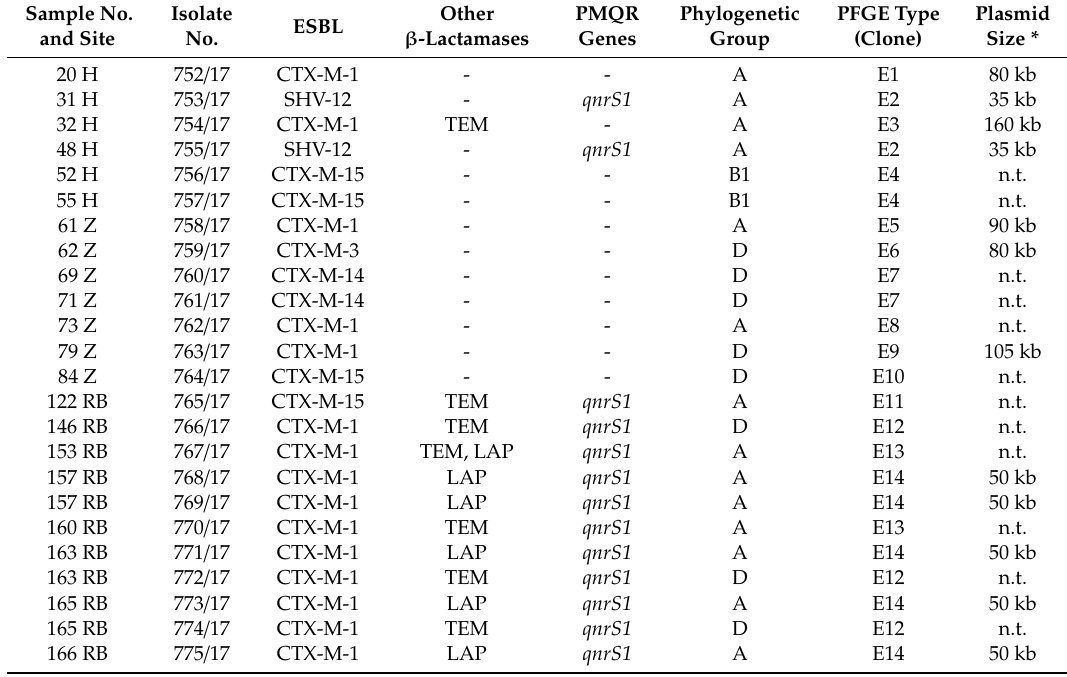
Table 2. Molecular characteristics of 24 ESBL-producing E. coli isolates from 21